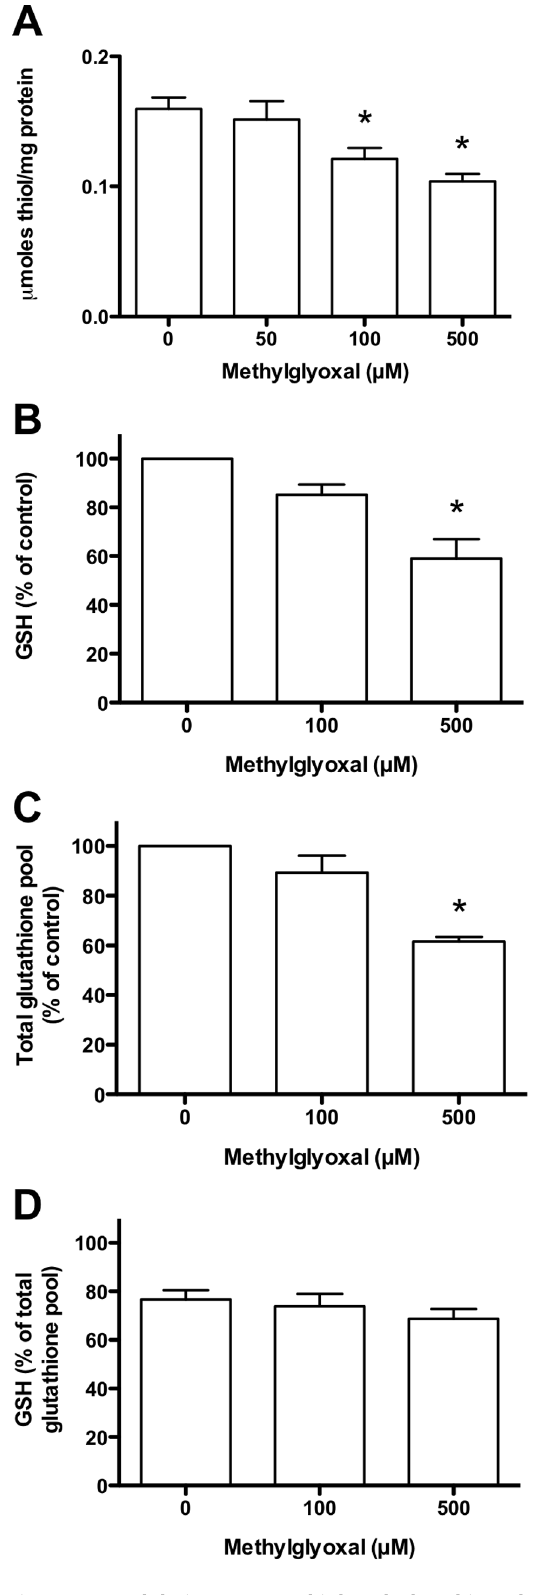
Figure 2. Modulation HCAEC thiol and glutathione levels by MGO. HCAEC were incubated with 0–500 m M MGO in serum-free medium for 1 h at 37 u C, prior to lysis and analysis. (A) Total thiols